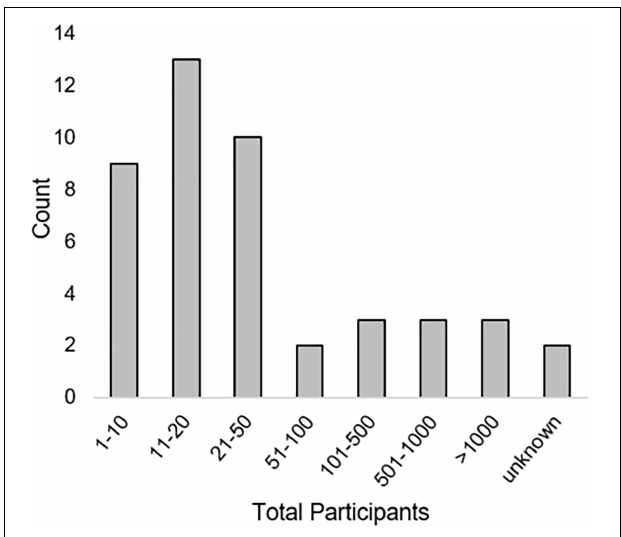
FIGURE 3 | Total number of participants included in